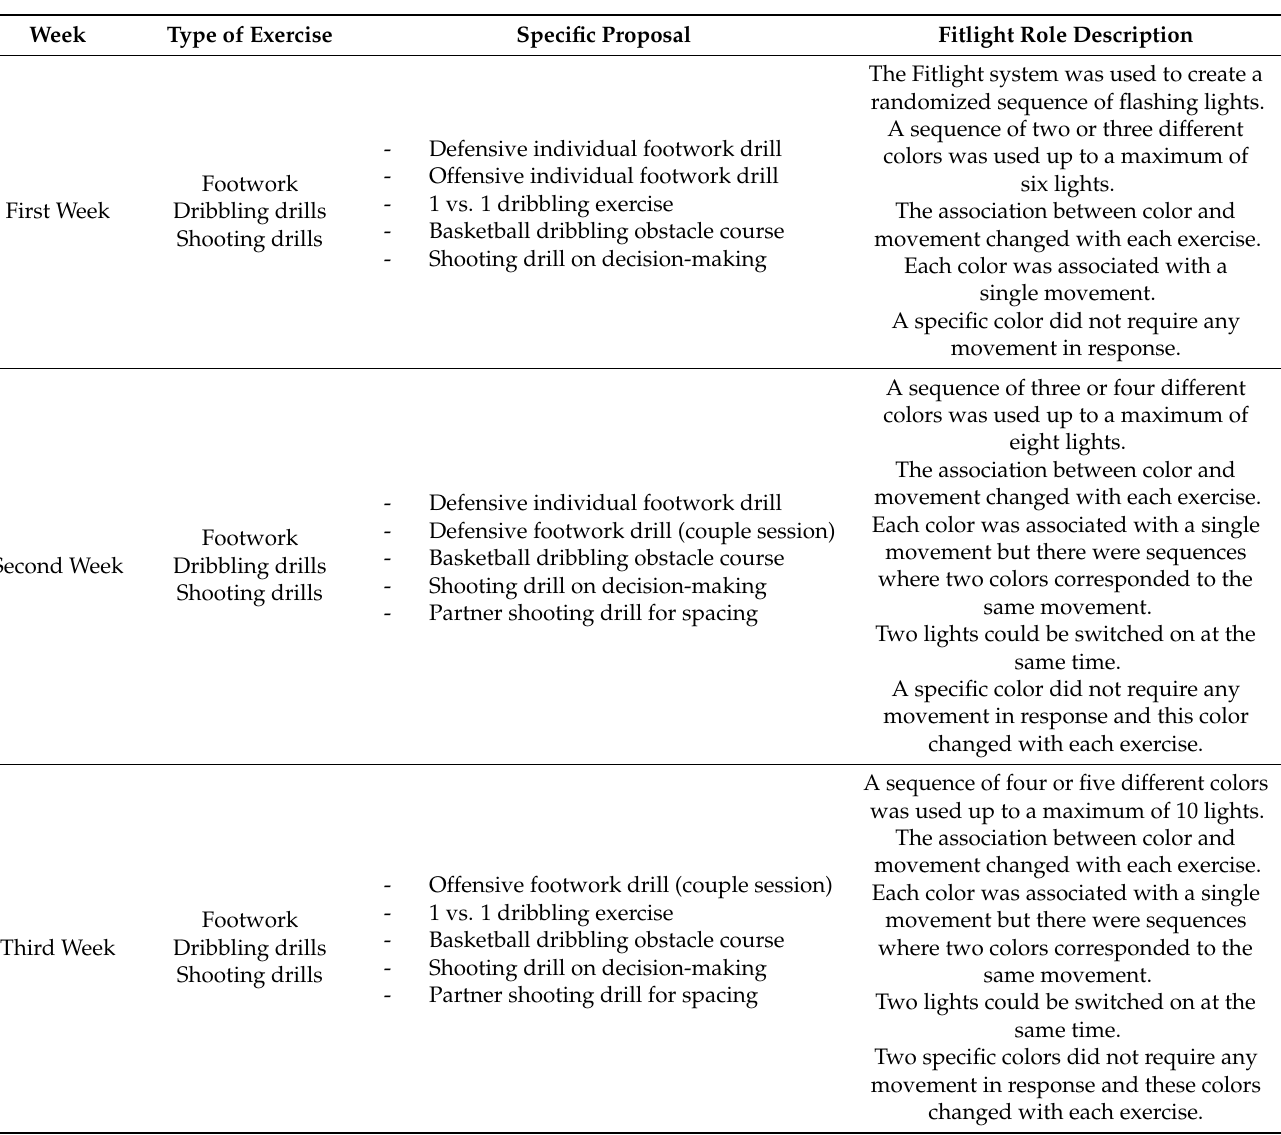
Table 1. Fitlight training program